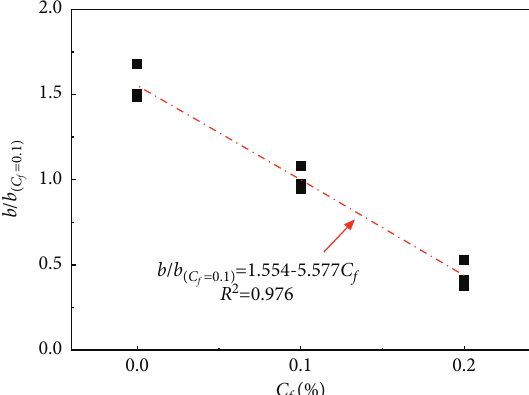
Figure 23: Relations between parameter b and C